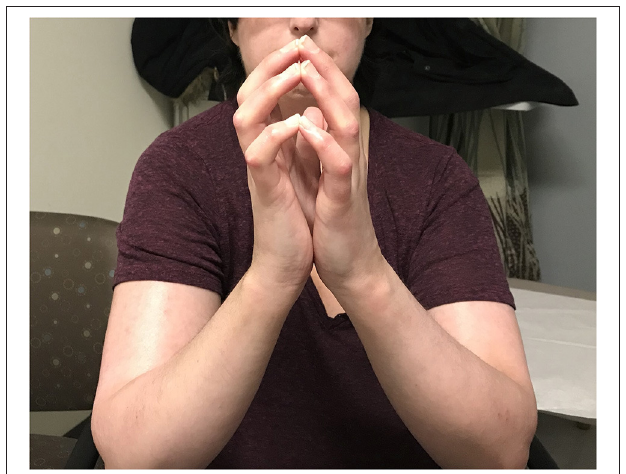
FIGURE 3 | Nailfold video capillaroscopy for our patient showing a late pattern described in SSc. (A) Note the capillary disorganization and decreased capillary density present before autologous hematopoietic stem cell transplantation. (B) Repeat nailfold video capillaroscopy examination 12 months post HSCT. Note the increased capillary density and improved organization after transplant.